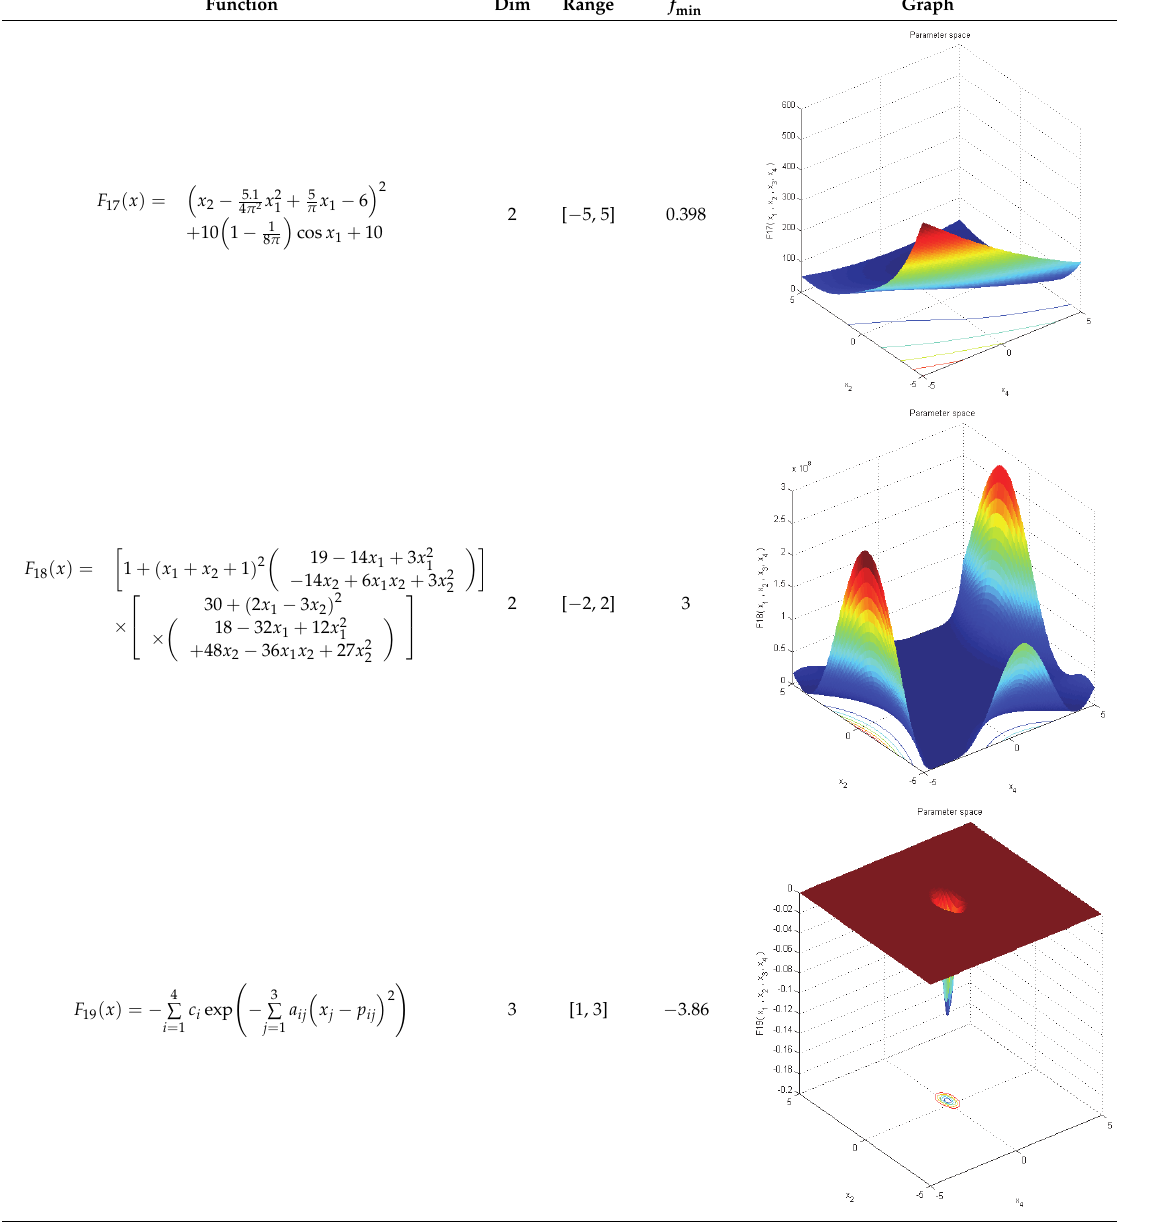
Function Dim Range f min